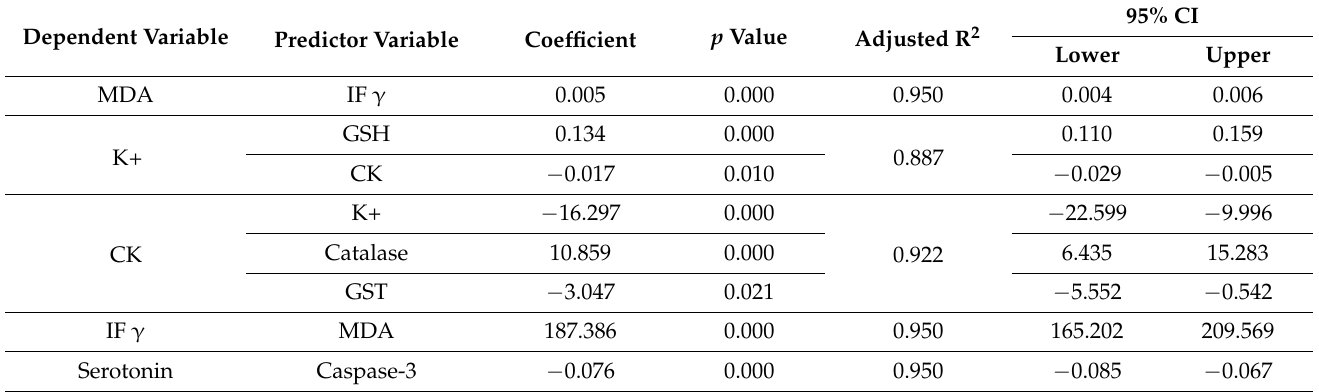
Table 2. Multiple regression using the stepwise method for measured parameters as a dependent